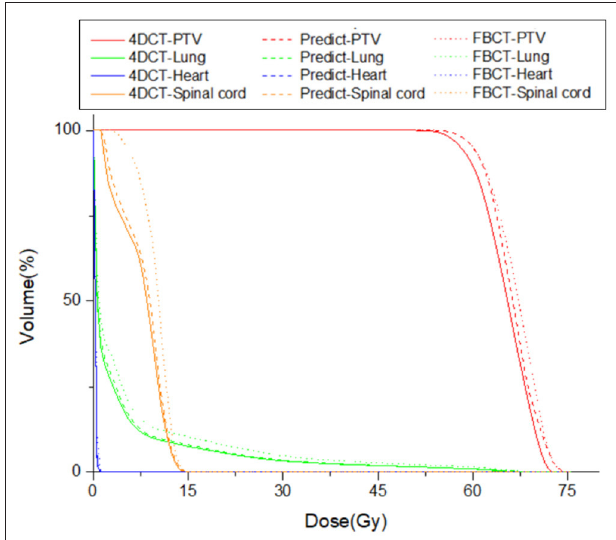
FIGURE 6 | Comparison of the dose-volume histogram (DVH) of one case under the 3 treatment plans: Plan 4DCT (solid line), Plan predict (dash line), and Plan FBCT (dot line).